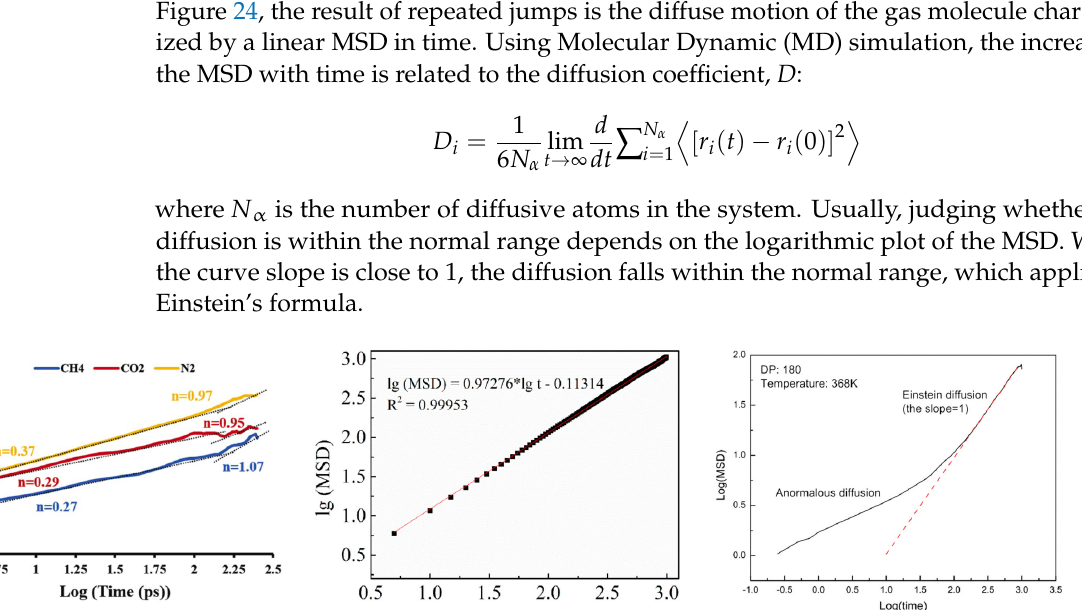
crease in pressure, due to the augmentation of the intermolecular force of PVA–H 2 O.